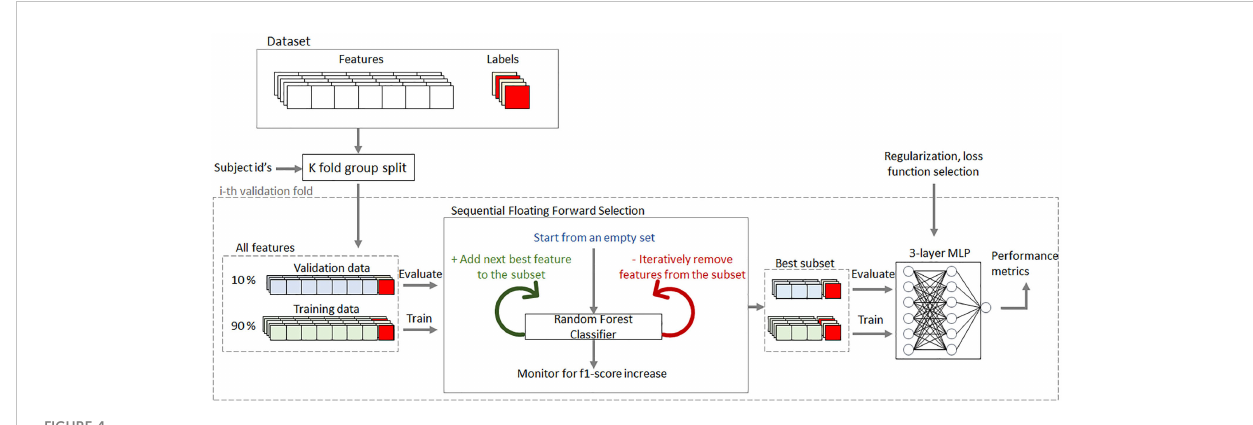
FIGURE 4 Feature selection and classi fi er evaluation